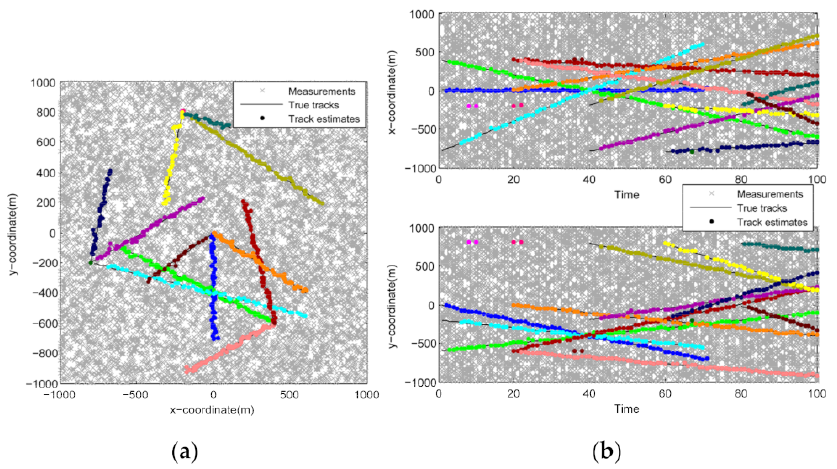
Figure 4. Track estimates of the proposed filter and ground truths for a sample run ( λ = 100, p D , k = 0.9). ( a ) The true and estimated trajectories of targets. Different trajectories estimated by the proposed filter are denoted by different colored dots. ( b ) The true and estimated trajectories of targets in x and y coordinates, respectively. © 2021 IEEE.